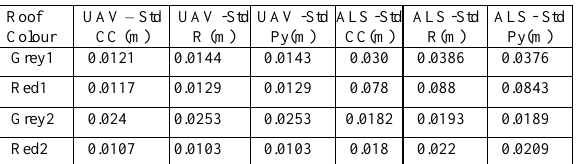
Table 2. Best plane fit errors comparison